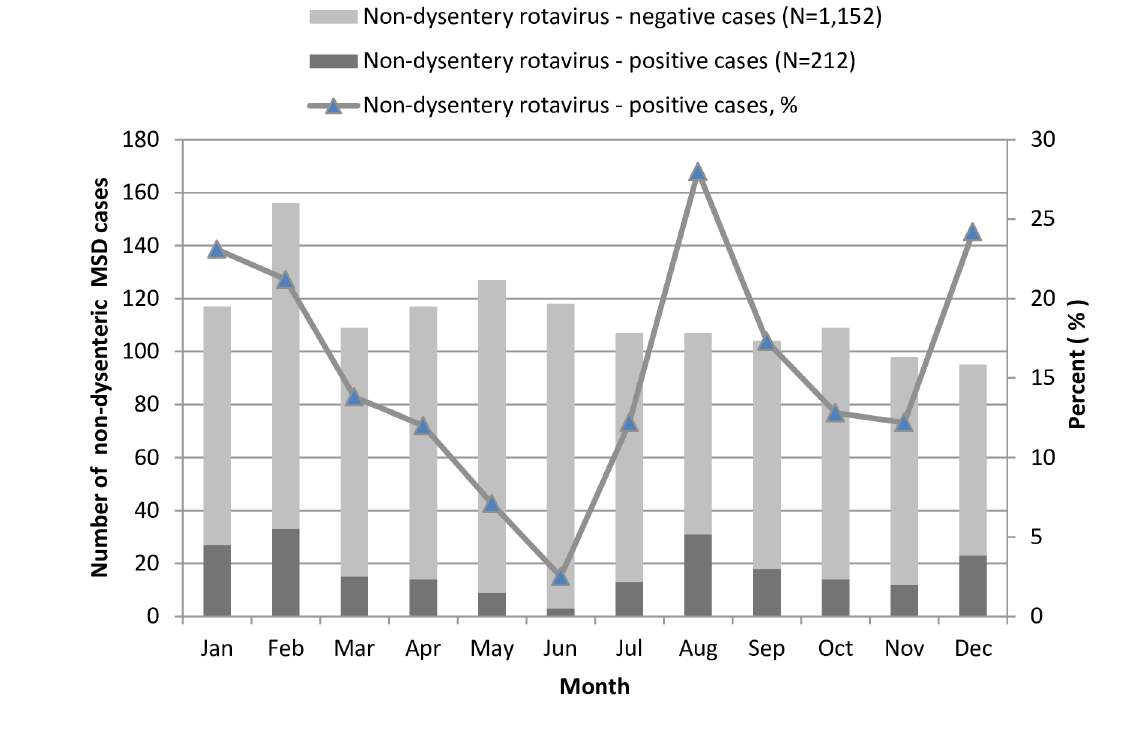
Fig 4. The seasonal distribution of rotavirus-positive compared with negative cases among children with non-dysenteric moderate-to-severe diarrhea (MSD) in western Kenya, January, 2008- February,